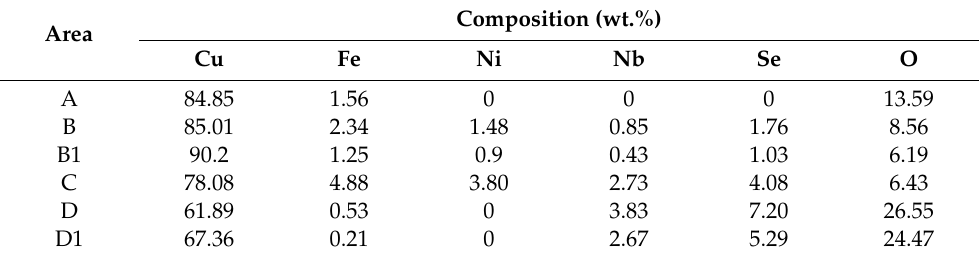
Table 3. EDS of worn surface of Cu/Ni/NbSe 2 composites (mass fraction/wt.%).